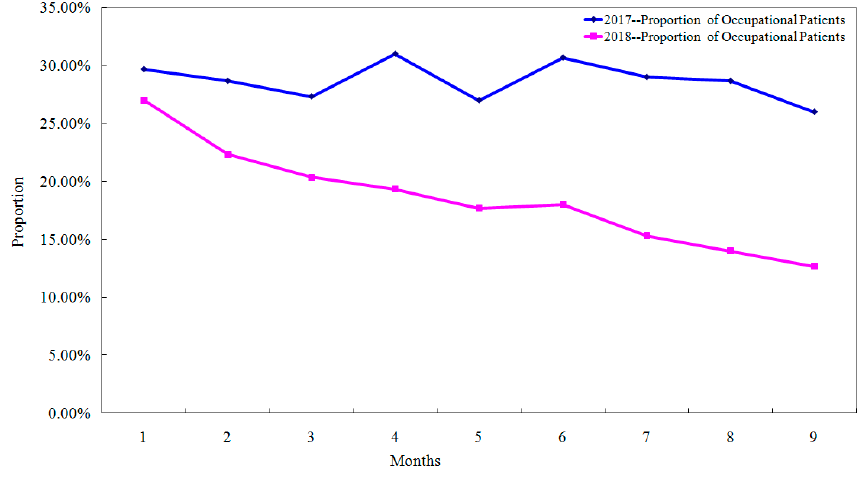
Figure 13. Comparison of the proportion of occupational patients in the company in the same month of 2017 and 2018.